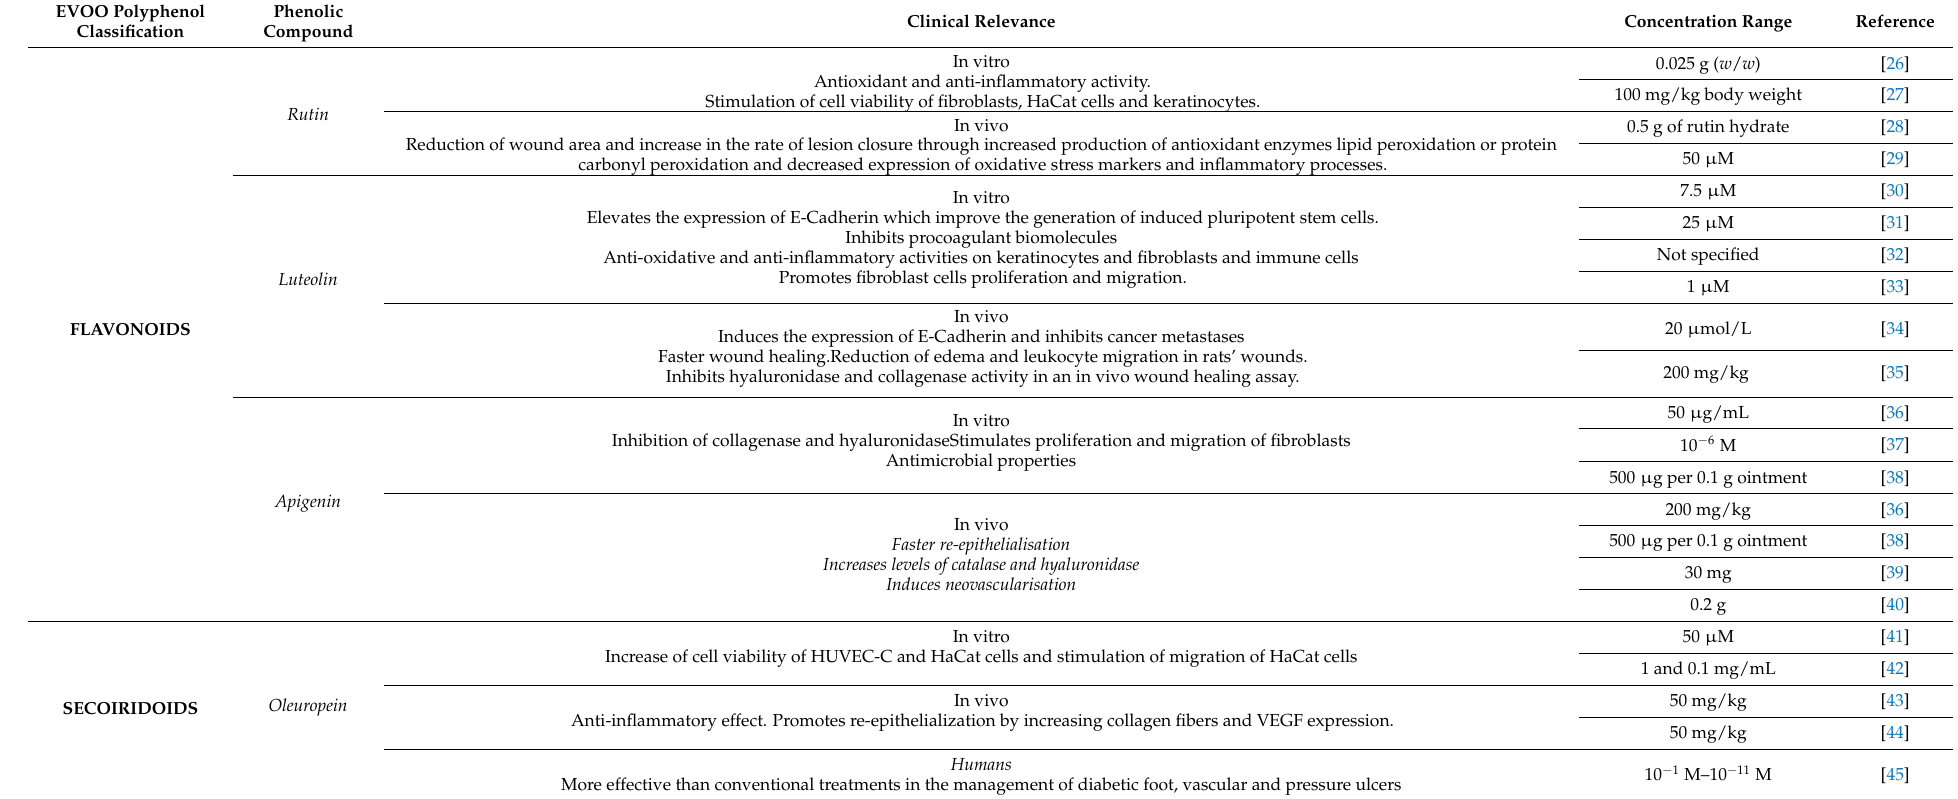
Table 1. Summary of the role of phenolic compounds in wound